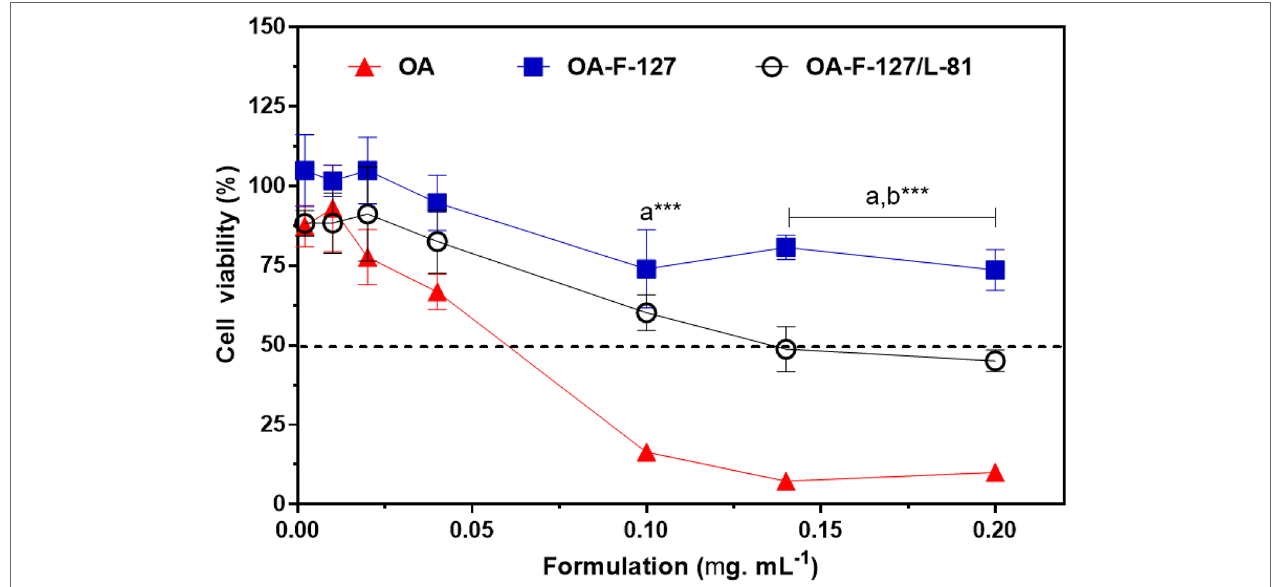
FIGURE 5 | Effects of organogels formulations on HaCat cells determined by MTT reduction test. Data expressed as mean ± standard deviation with n = 6 replicates/concentration). F-127, Pluronic ® F-127; L-81, Pluronic ® L-81; OA, oleic acid. a- OA-F-127 and OA-F-127/L-81 vs . OA; b- OA-F-127 vs . OA-F-127/L-81. *** p <